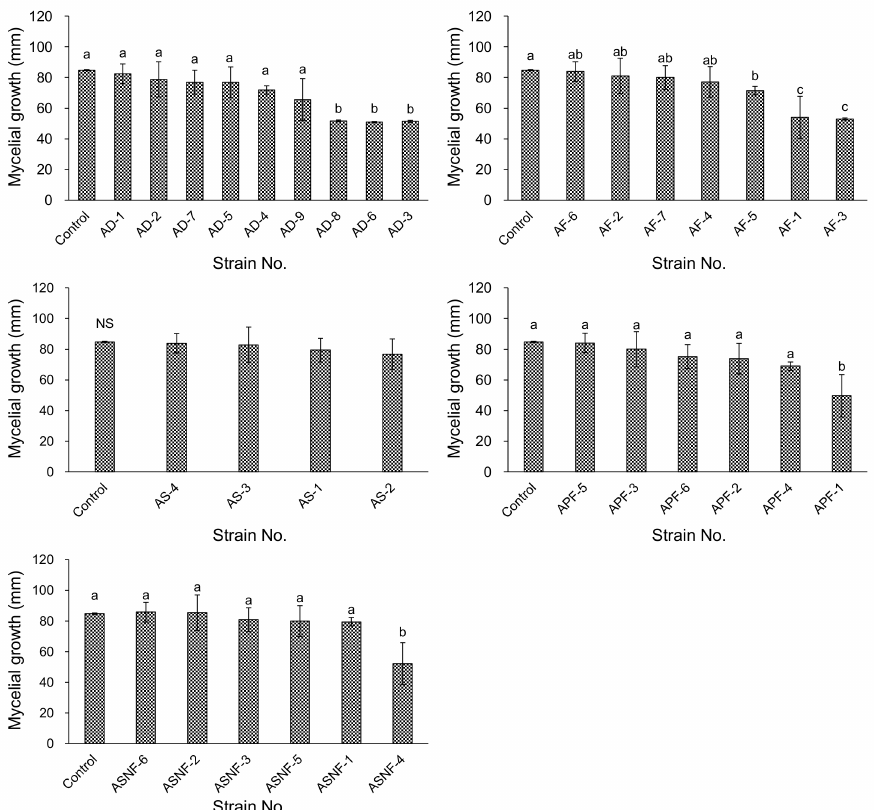
Figure 1. Antifungal activity of bacterial isolates from five anaerobically digested slurries (ADSs) against Fusarium oxysporum f. sp. spinaciae (Fos), indicated as mycelial growth (bars ± SD) by a co-culture test. AD, dairy cow manure; AS, sewage sludge; AF, food garbage; APF, pig manure + food garbage; ASNF, sewage sludge + night soil sludge + food garbage. SD, standard deviation of the mean. Bars with the same letter are not significantly different based on Tukey’s HSD test ( p < 0.05; n = 4). Table 3. Disease severity (DS) of Fusarium wilt of spinach and inhibitory effect (IE) 28 d after seedling.